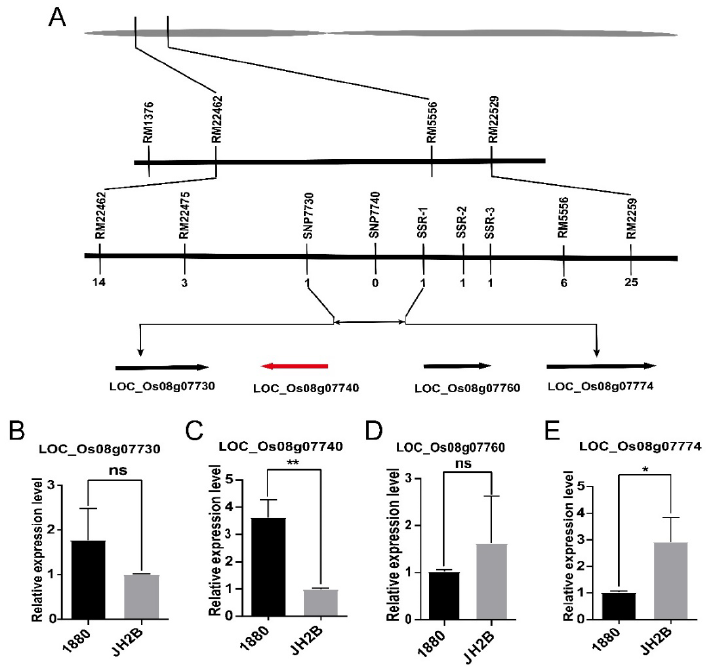
Figure 2. Identification of candidate heading date gene for OsHd8 . ( A ) Fine mapping of OsHd8 . The OsHd8 locus was detected on chromosome 8. Positional cloning narrowed to a 31.8 kb region be- tween marker SNP7730 and SSR-1. The red colors marked gene LOC_Os08g7740 was the candidate gene; ( B – E ) Comparison of the relative expression levels of four candidate genes among 1880 and JH2B. Values are means ± SEM (n = 3), The asterisks indicate significant differences (*, p < 0.05; **, p < 0.01; Student’s t-test).